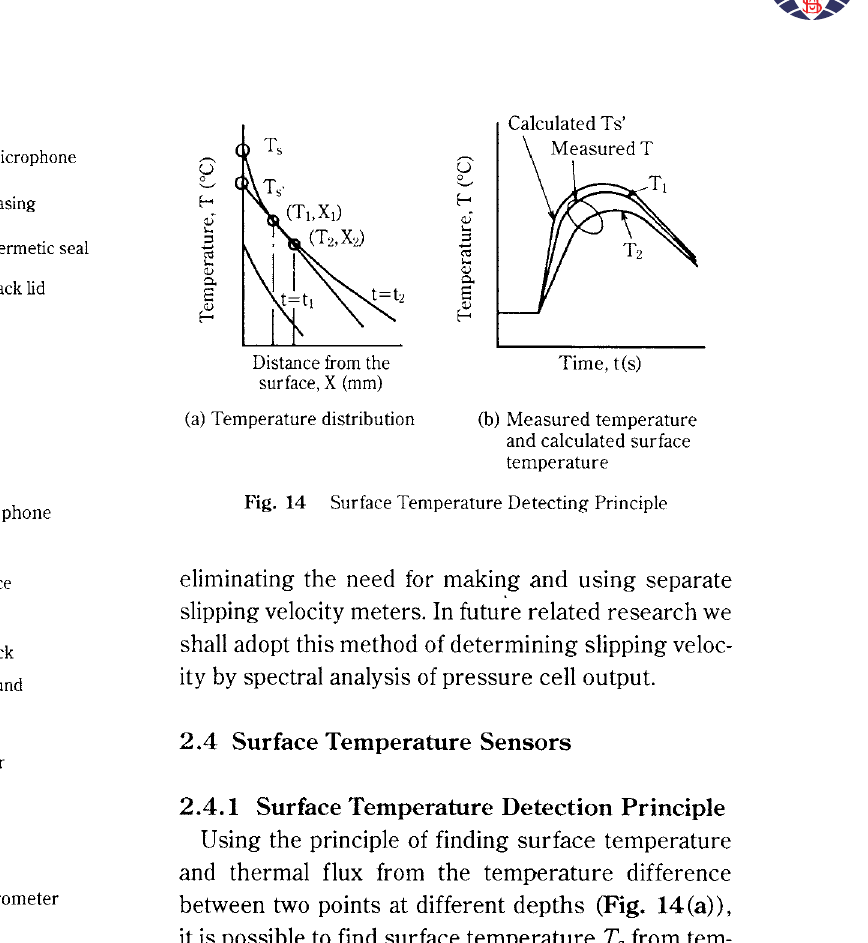
Fig. 14 Surface Temperature Detecting